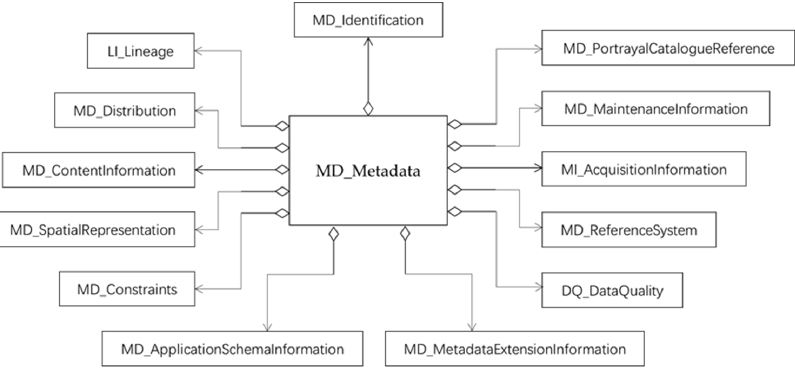
Figure 14. Overall metadata structure of ISO 19115-2.